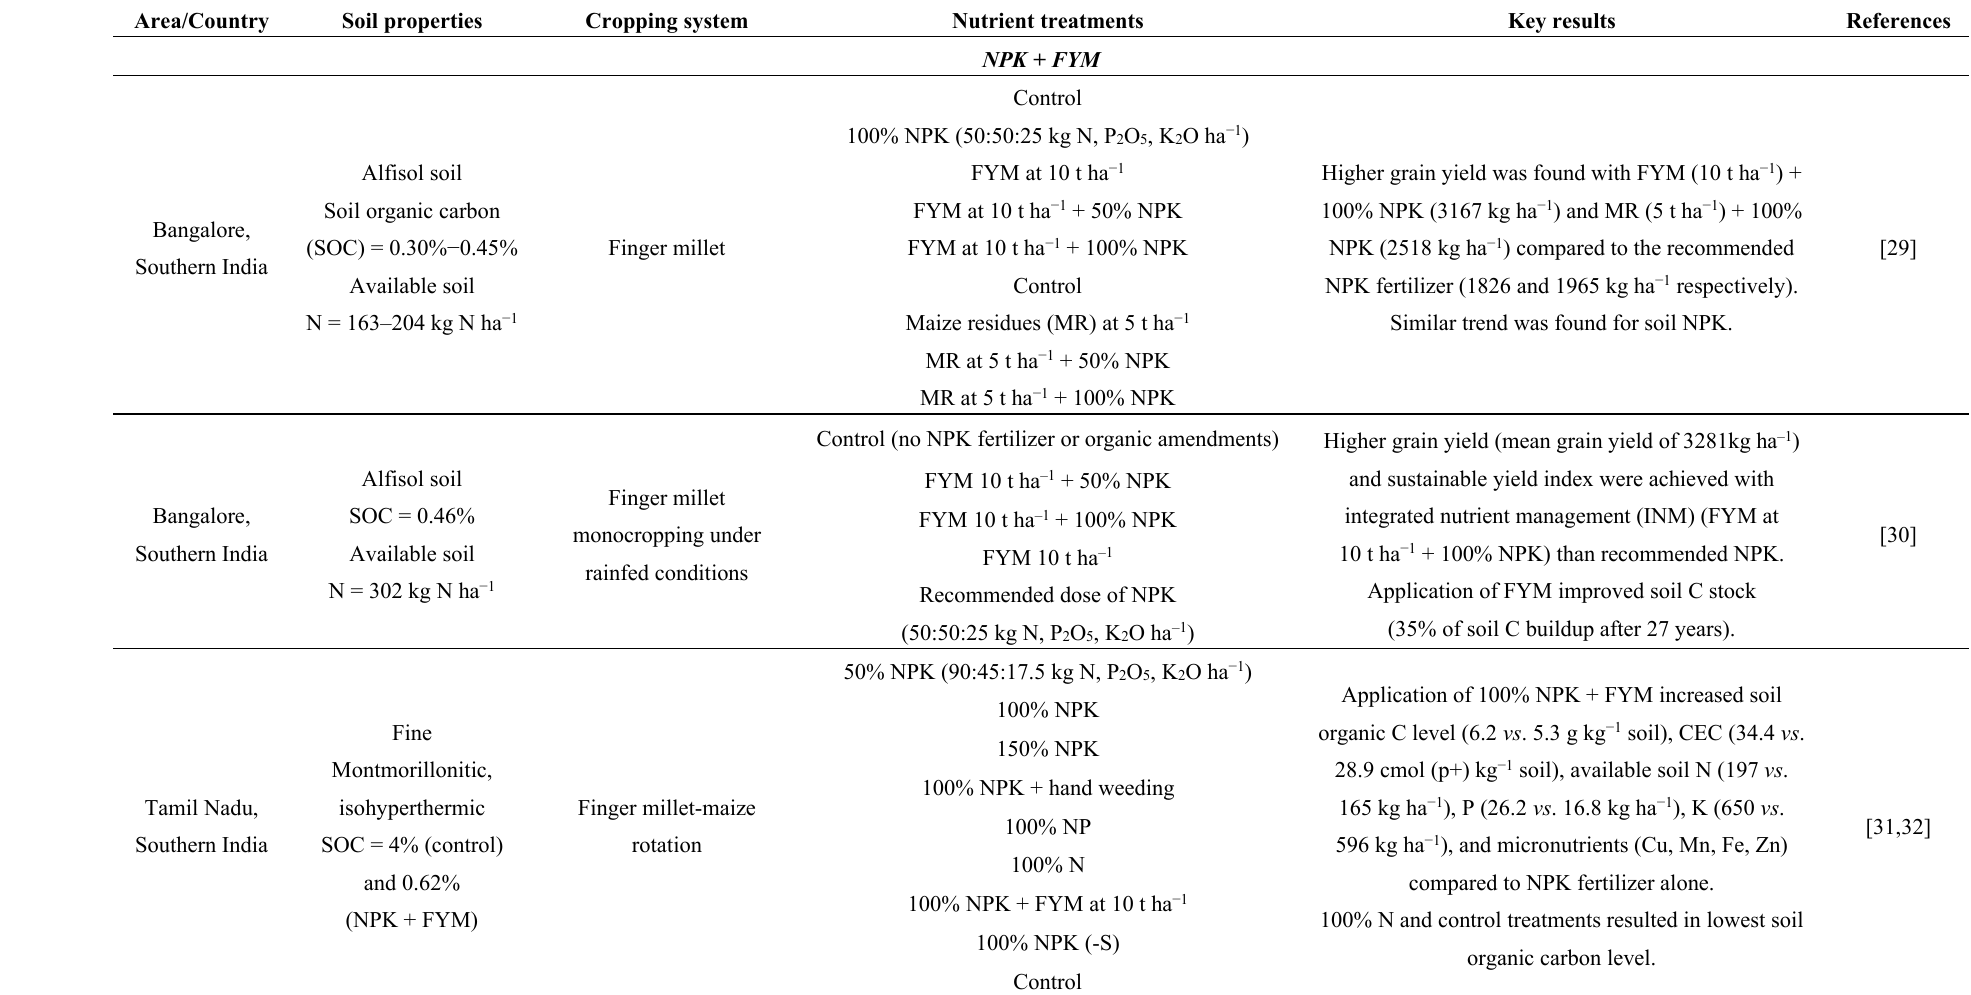
Table 2. Effect of different fertilizer management practices on finger millet growth, yield, and soil